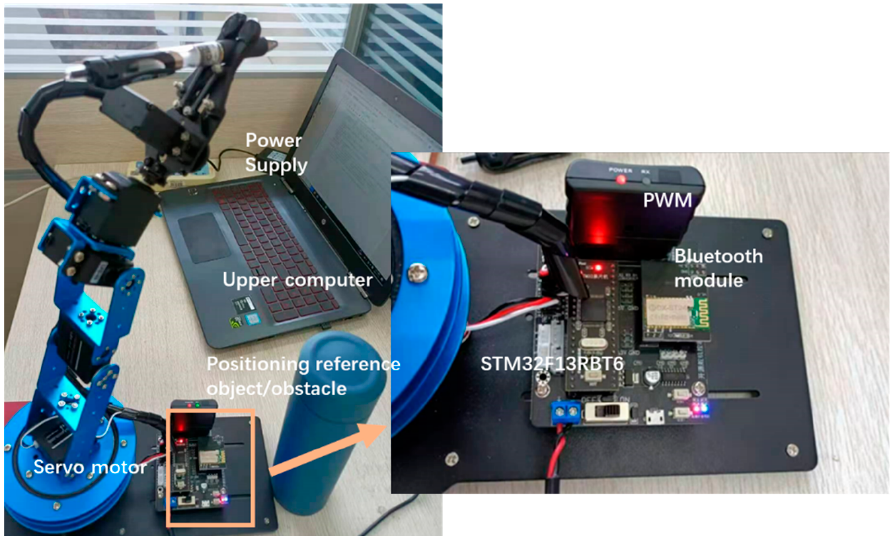
Figure 1. Manipulator experiment